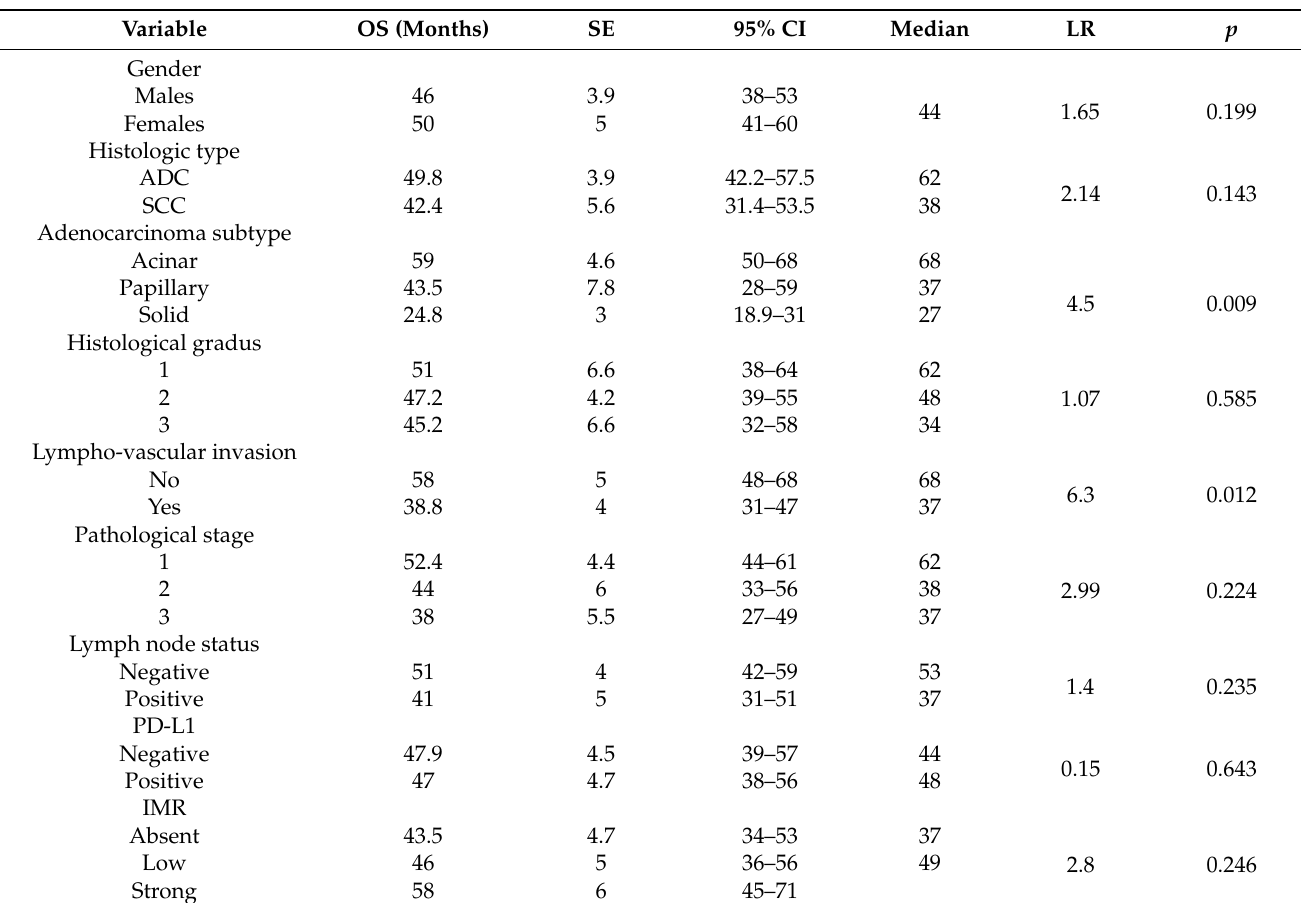
Table 4. Overall survival of patients with surgically treated NSCLC according to analysed variables.